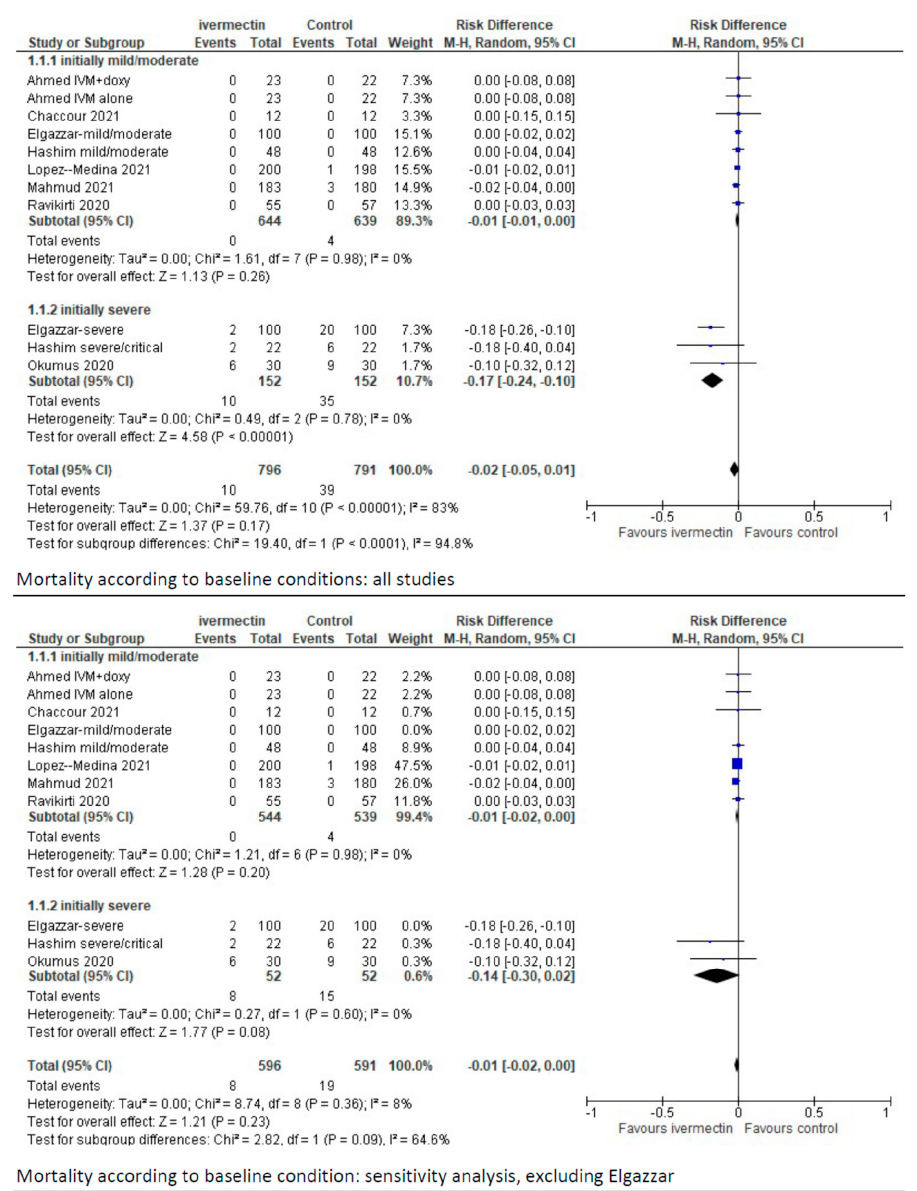
Figure 1. Forest plot of the comparison. Outcome: mortality according to baseline conditions. Top: all studies; bottom: sensitivity analysis excluding Elgazzar et al. [2].